Question: Express in one sentence what the figure is showing.
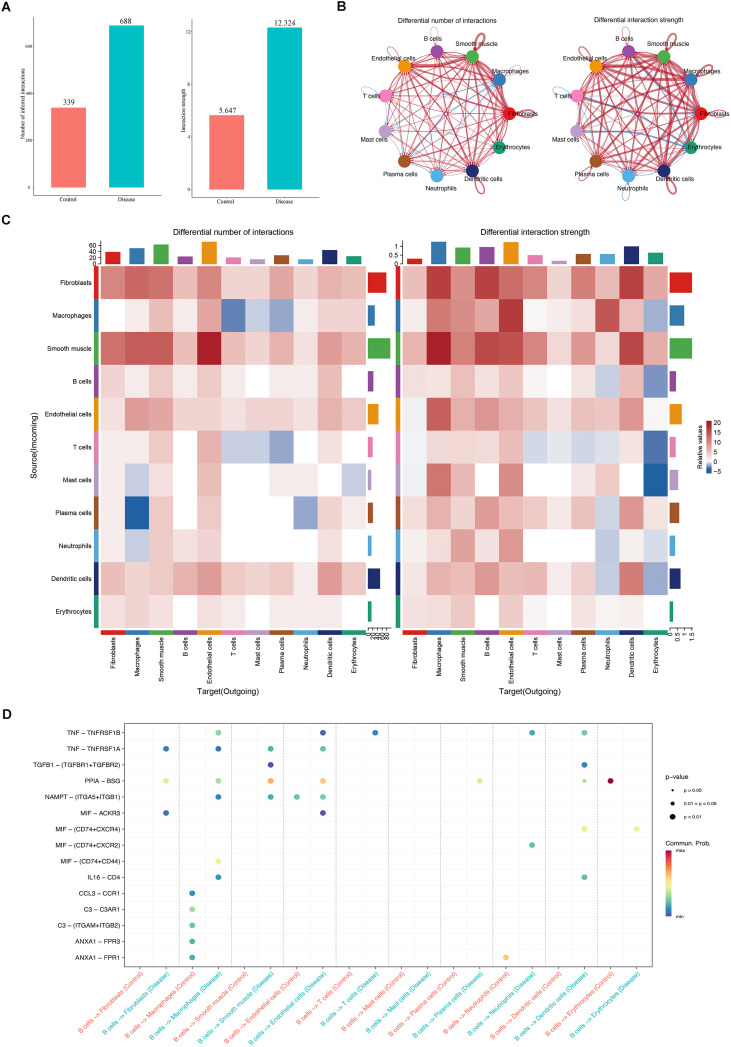
Answer: Cell communication. (A) AAA tissues exhibit a greater number of intercellular communication links compared to controls. (B) The circos plot reveals that B cells receive signals from almost all major cell types present in the abdominal aortic wall. (C) Communication between B cells and fibroblasts, endothelial cells, dendritic cells, and smooth muscle cells appears particularly frequent. (D) Analysis identified several significantly upregulated ligand-receptor pairs in AAA (B cells-fibroblasts, B cells-smooth muscle cells, B cells-endothelial cells).